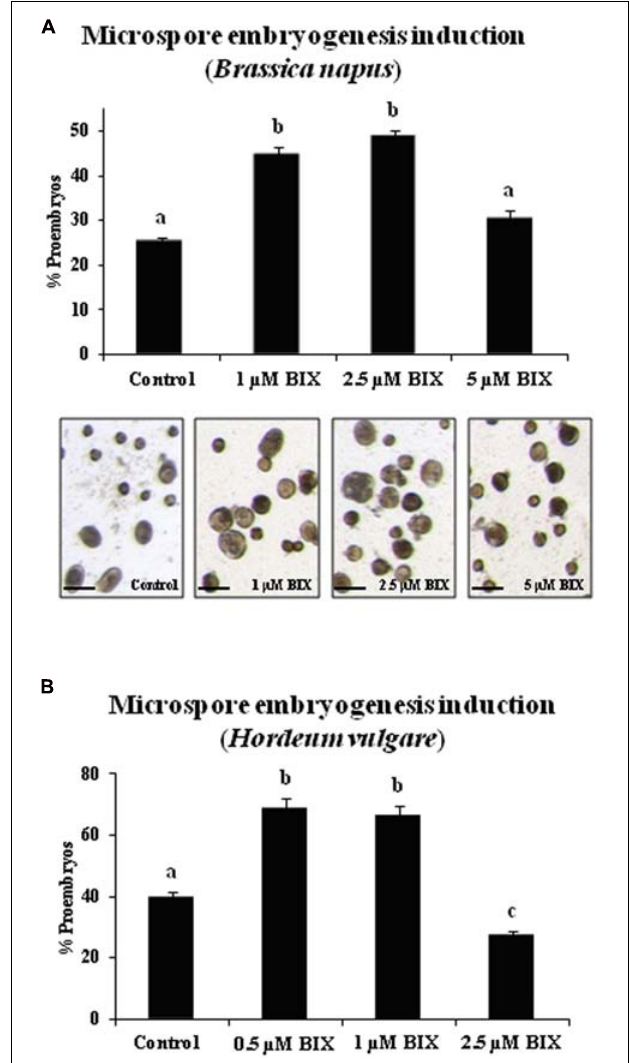
FIGURE 8 | Effects of BIX-01294 short treatments on microspore embryogenesis induction of Brassica napus and Hordeum vulgare . (A) : Quantification of microspore embryogenesis induction and representative micrographs of control and BIX-treated cultures of Brassica napus . (B) : Quantification of microspore embryogenesis induction in control and BIX-treated cultures of Hordeum vulgare . Histograms show percentages of proembryos formed in microspore cultures untreated (control) and after short treatment (4 days) with BIX-01294 at different concentrations (1, 2.5, and 5 µ M in B. napus , 0.5, 1, and 2.5 µ M in H. vulgare ); bars in columns indicate the SEM; different letters on columns indicate significant differences according to ANOVA and Tukey’s tests at p < 0.05. Micrographs show proembryos (larger, dense-rounded structures) in representative areas of control and